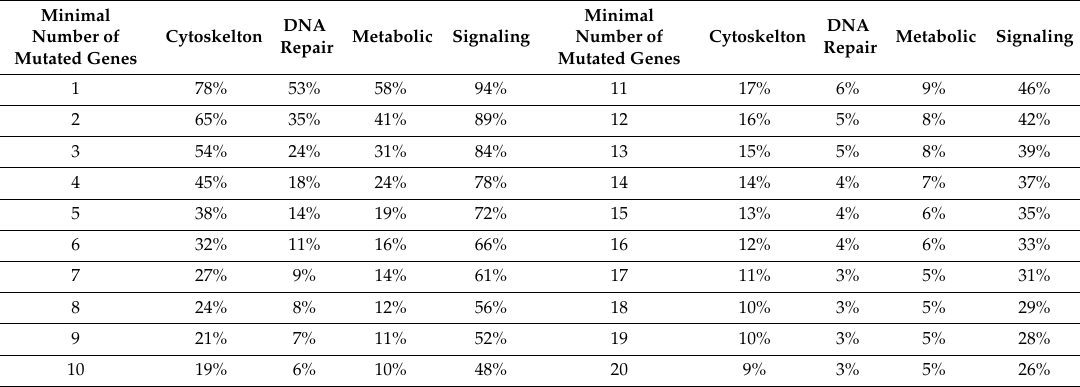
Table 2. Percentage of 4910 tumor samples with mutated genes of four pathway